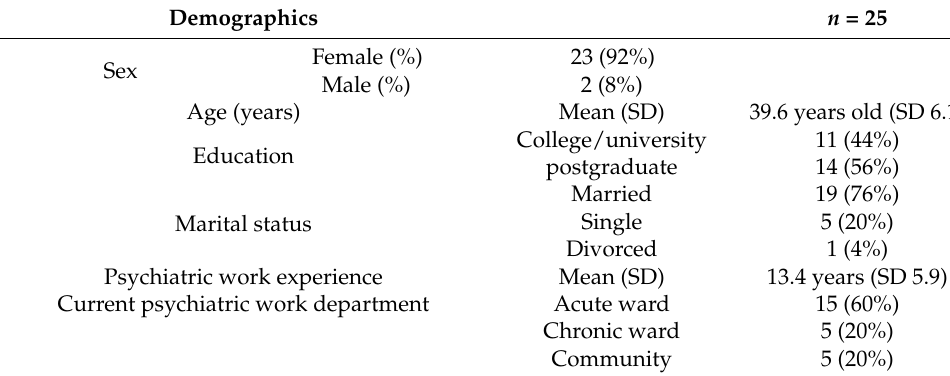
Table 1. Sociodemographic characteristics of the